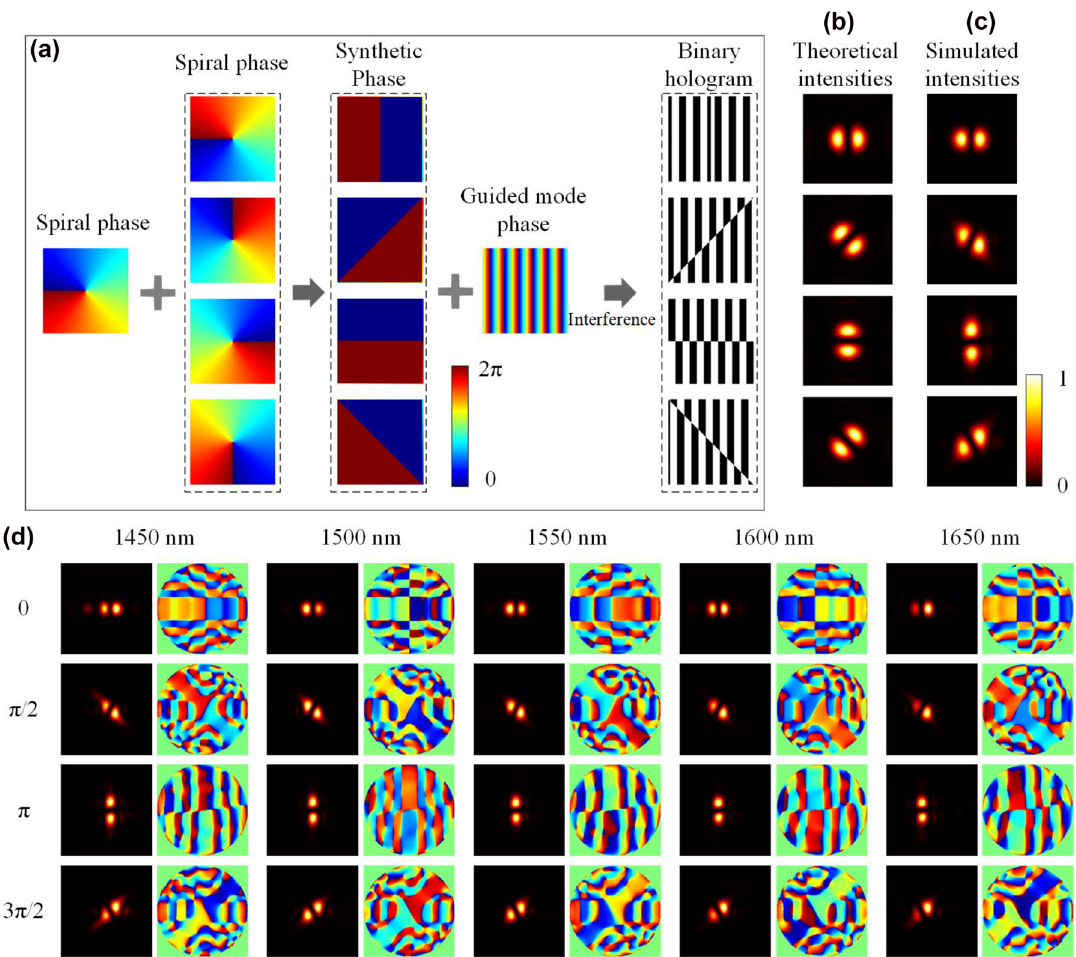
Figure 4: LP beam generation. (a) The design principle of the holographic subwavelength surface grating. (b, c) The theoretical and simulated intensity profiles of rotated LP beams at the wavelength of 1550 nm. (d) The simulated electric field intensity and phase profiles of the generated LP beams at 1450 nm, 1500 nm, 1550 nm, 1600 nm, and 1650